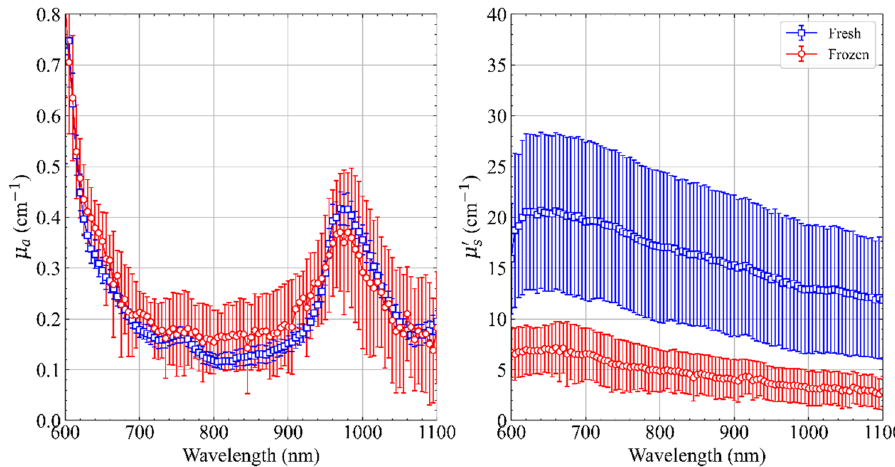
Figure 3. Difference in the average optical properties of the same 5 ex vivo porcine pancreatic samples measured both in the ‘fresh’ and ‘frozen’ state. Each sample is measured at 3 positions (A–C). The error bars represent the standard deviation over the 15 measurements.